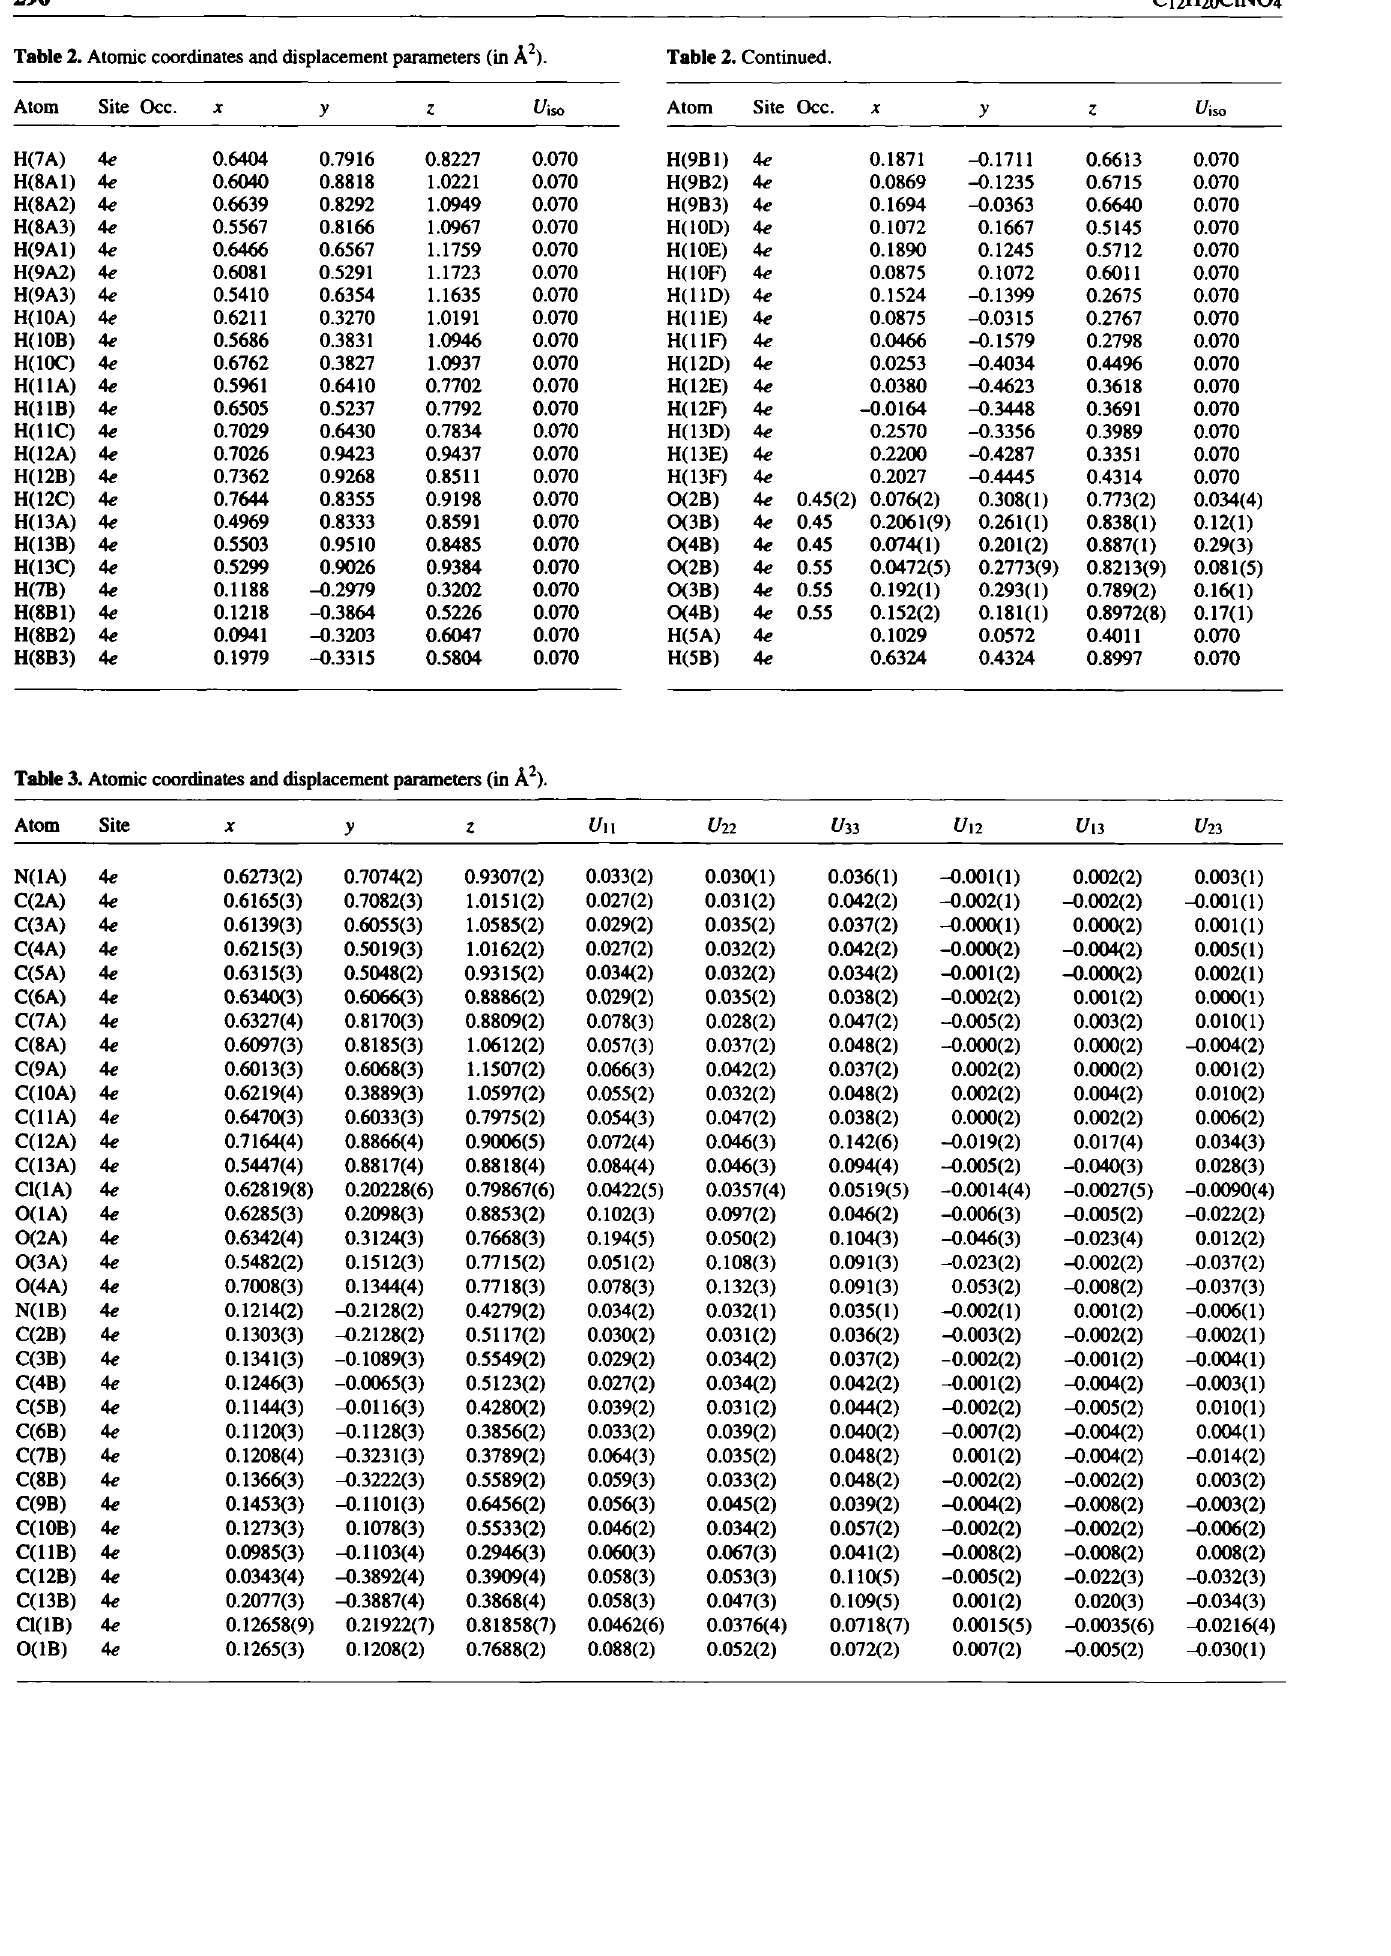
Table 2. Atomic coordinates and displacement parameters (in Â 2 ). Table 2. Continued.